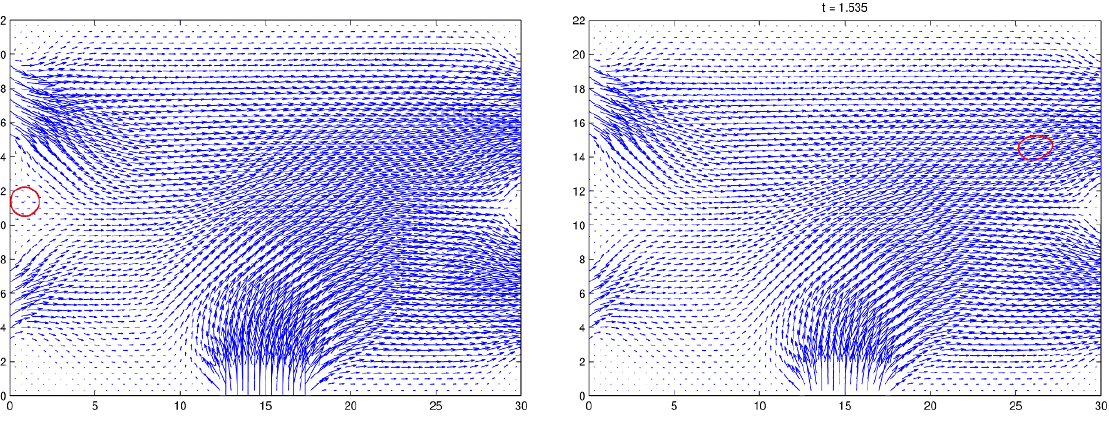
Figure 6. Velocity field and motion of a melanoma cell with SAW actuation: Initial state after injection (left) and state shortly before the cell leaves the separation channel